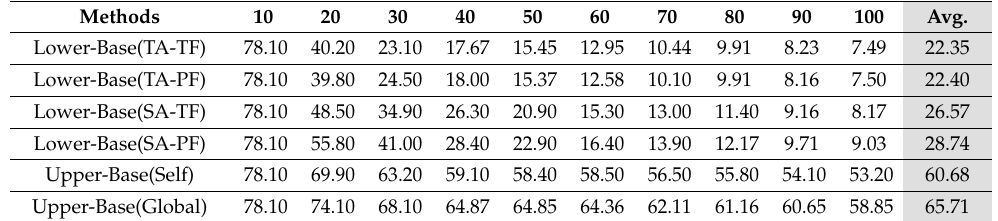
Table 4. Tiny-ImageNet: Comprehensive performance on intensive tasks.